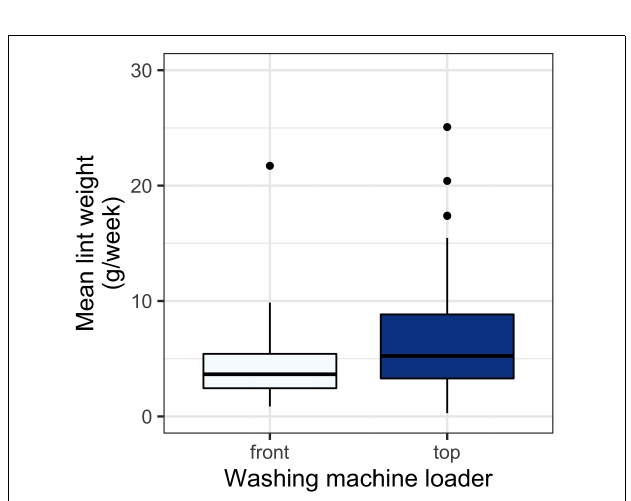
FIGURE 2 | Weight of lint in g/week for lint captured in household filters across different washing machine types. A t -test test revealed a significant difference between collection periods ( p < 0.05). Boxes represent 25th–75th percentiles; dark lines, medians; whiskers, 1.5 × the interquartile range (IQR); points, values outside 1.5 × the IQR.